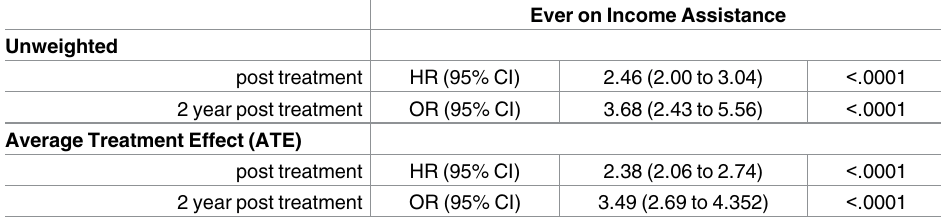
Table 4. Effect of EPPIS on ever using income assistance.